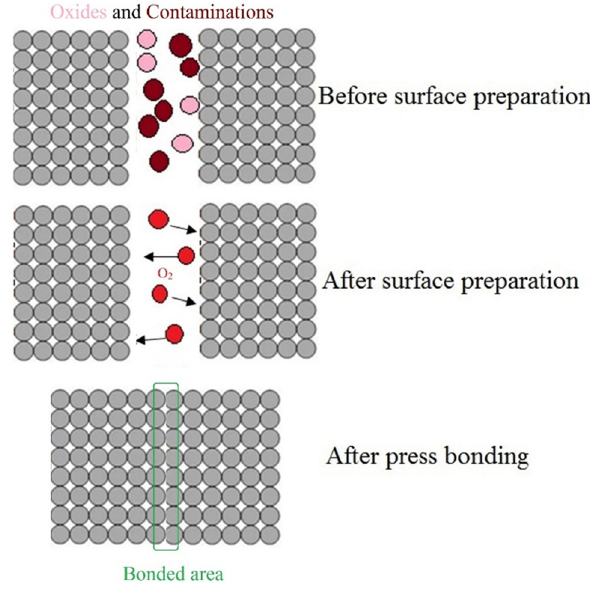
Figure 3: Atomic arrangement of composite samples during the bonding during the ARB process.